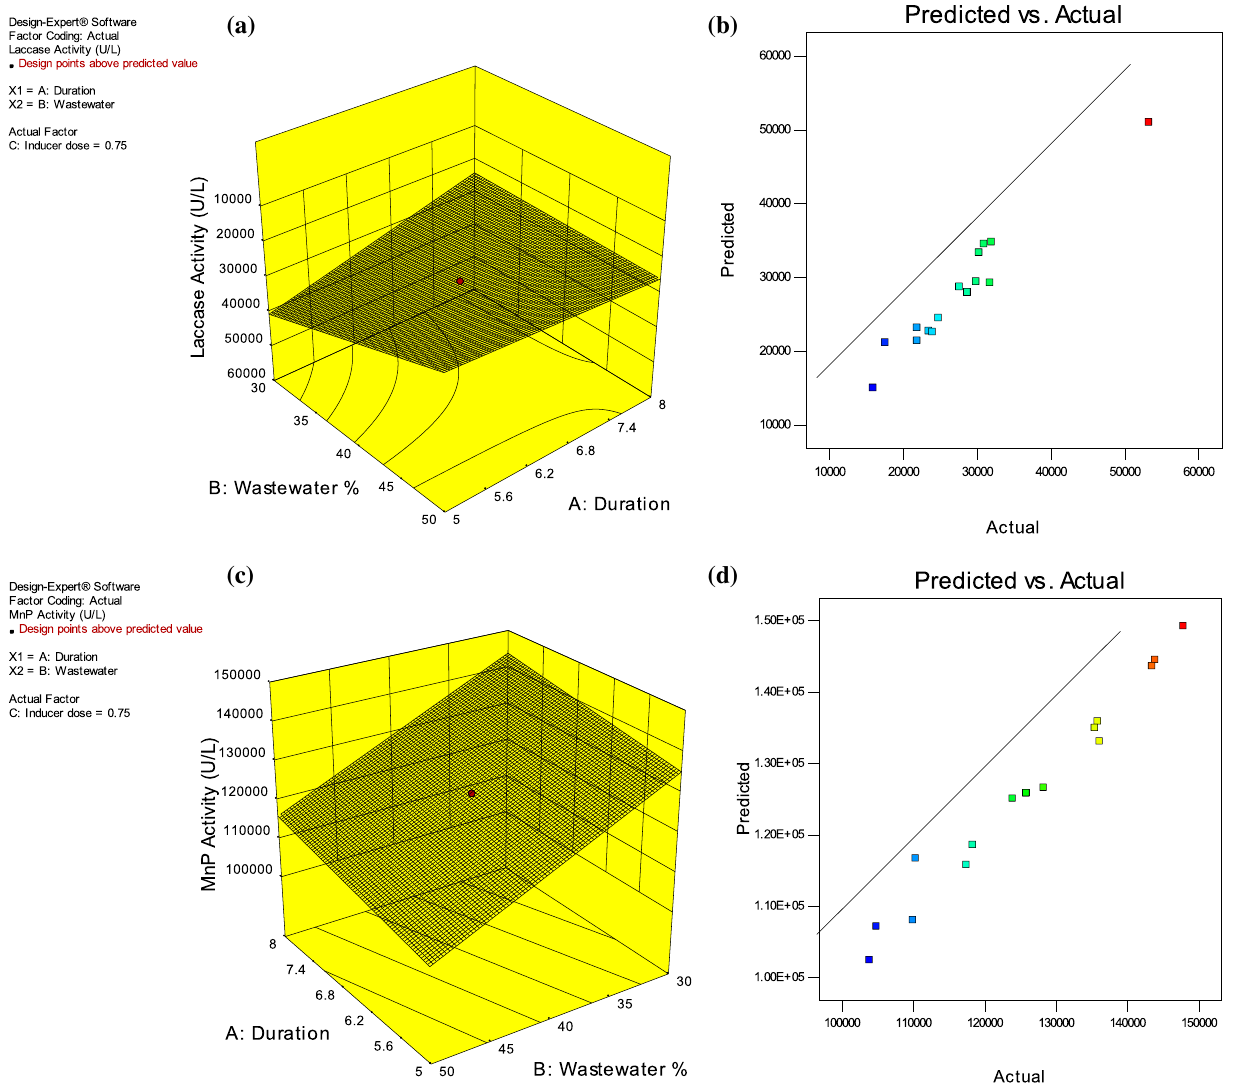
Fig. 3 Response surface plots ( a , c ) showing the mutual effects of time of duration and wastewater% for optimum laccase and MnP activity, respectively, while b , d show the actual and predicted values of laccase and MnP